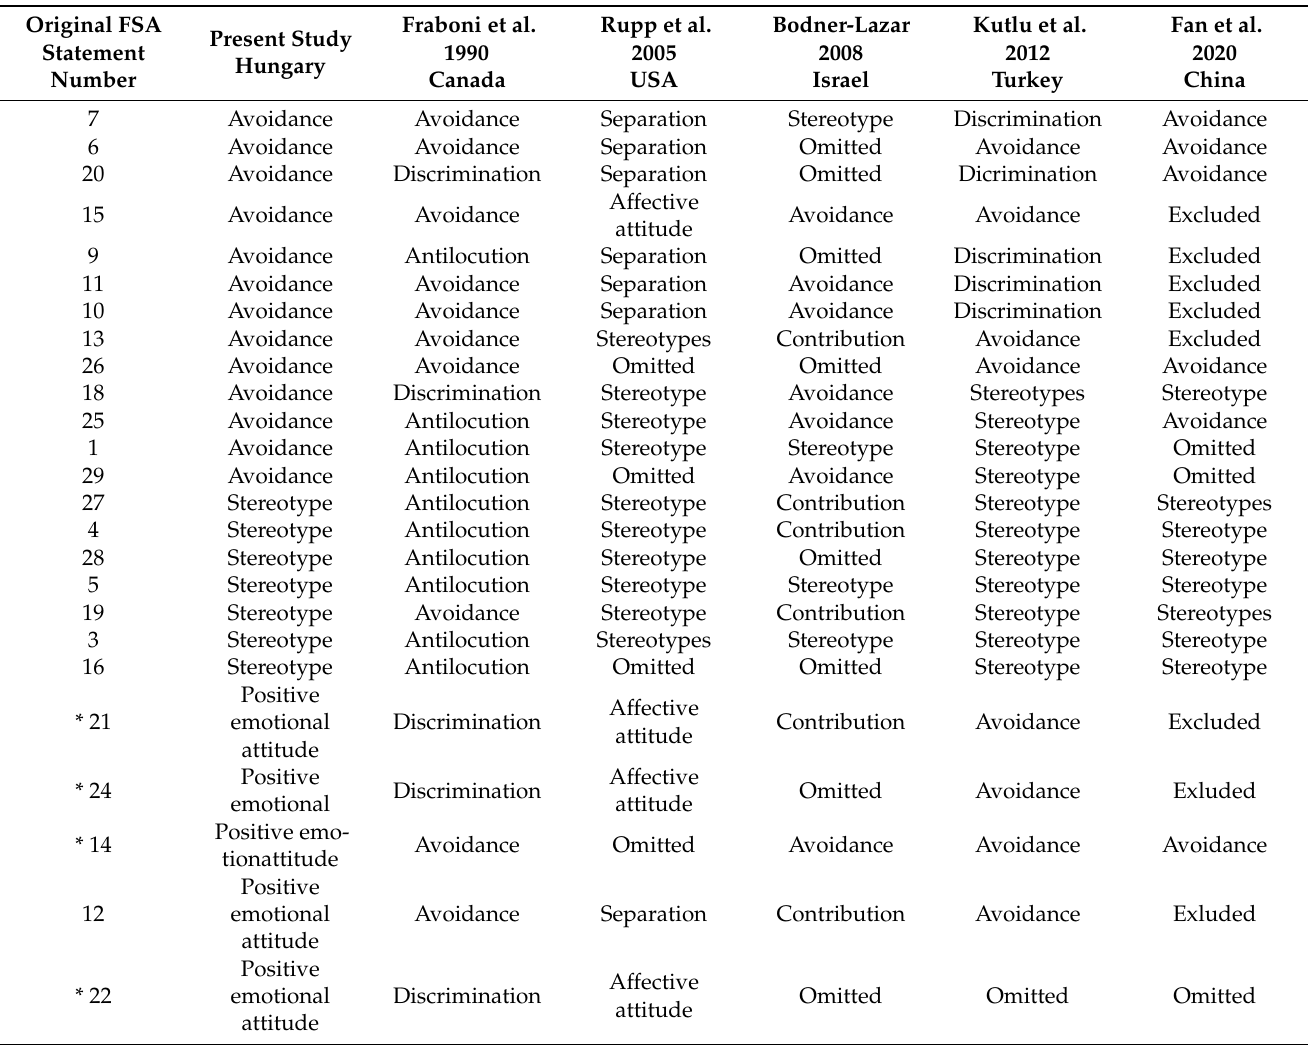
Table 3. Comparison of the interpretation of the scale items (item- factor associations) with previous international research. Original